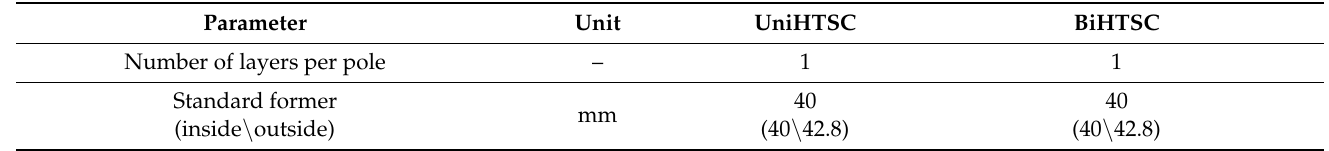
Table 6. Parameters of the unipolar and bipolar superconducting